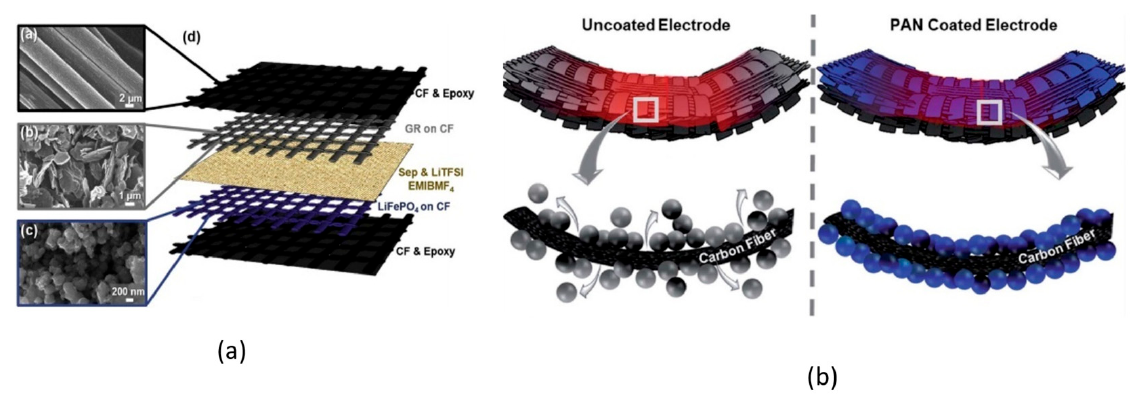
Figure 18. Structural battery with engineered interfaces from Moyer et al. [29,63]. ( a ) Carbon fiber battery layout. ( b ) PAN coating process.